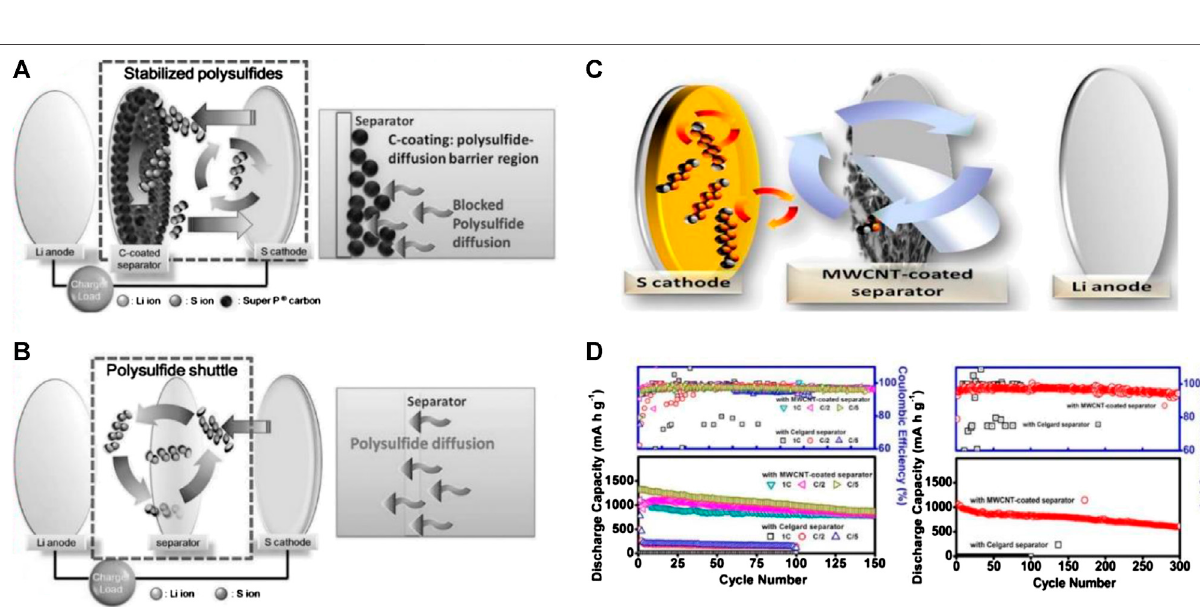
Frontiers in Energy Research |